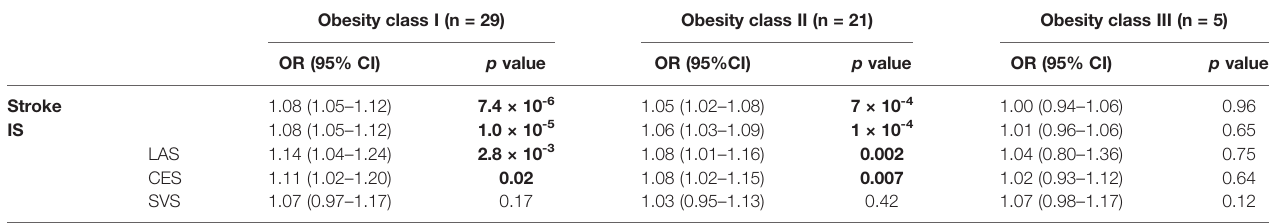
TABLE 1 | MR strati fi cation analysis of obesity classes I, II, and III with the risk of IS and IS subtypes using the IVW